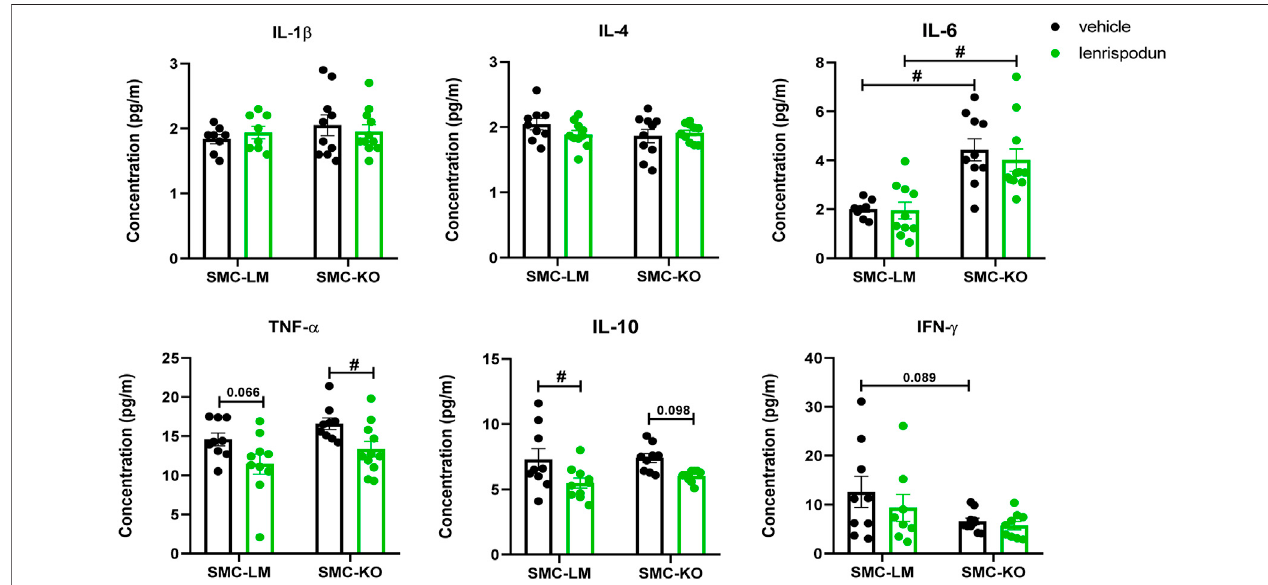
FIGURE4| Thelevel ofin fl ammatorycytokines in theplasmaofSMC-KOmiceversustheir SMC-LM, lenrispodun-treated samplesareshown ingreen. Values are expressed as means ± SEM; n (cid:1) 4 – 11; #, p < 0.05, two-way ANOVA followed by Bonferroni ’ s post hoc test.